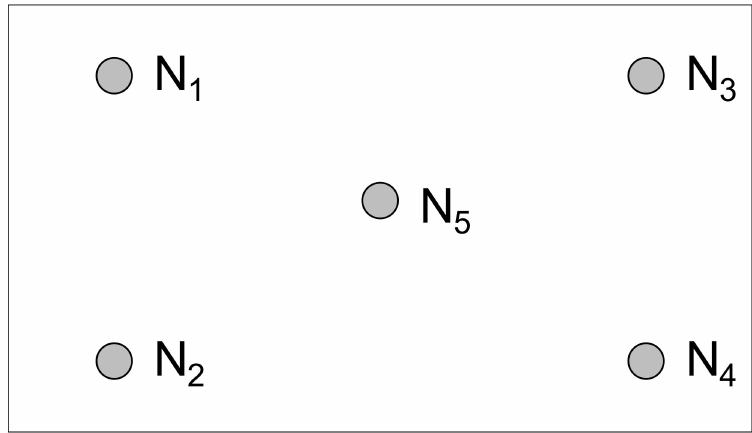
Figure 3. Positions on the substrate to measure the luminance.